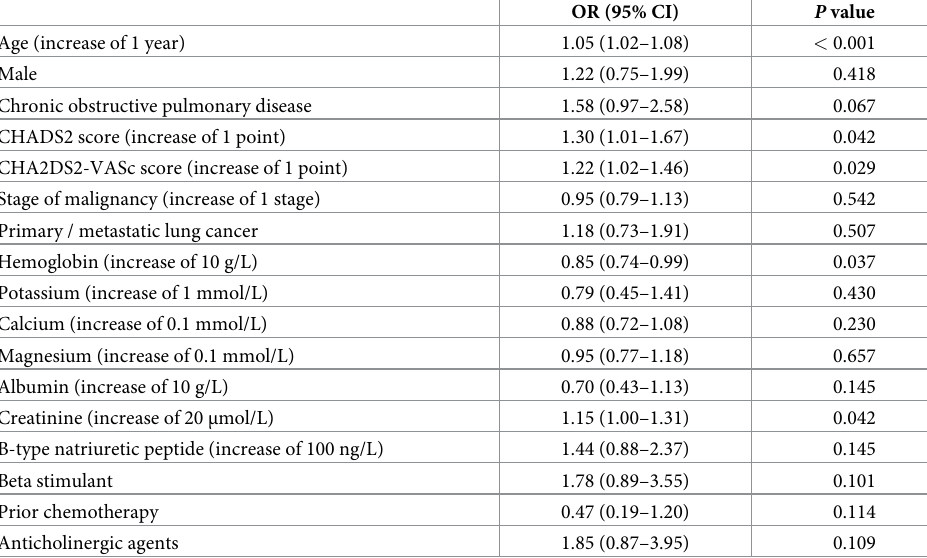
Table 3. Univariate logistic regression analysis for an incidence of perioperative atrial